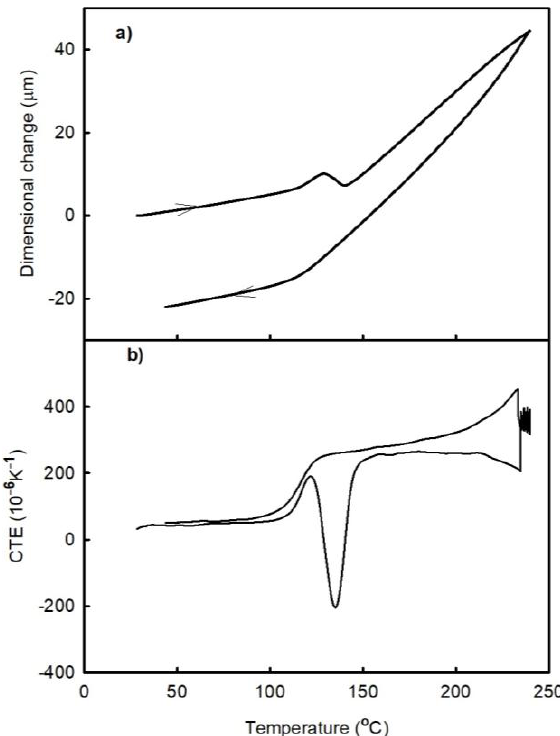
Figure 6. Temperature dependences of the ( a ) dimensional changes and ( b ) CTE of the A1 sample (FR4 laminate) observed after the heat treatment at 180 °C.